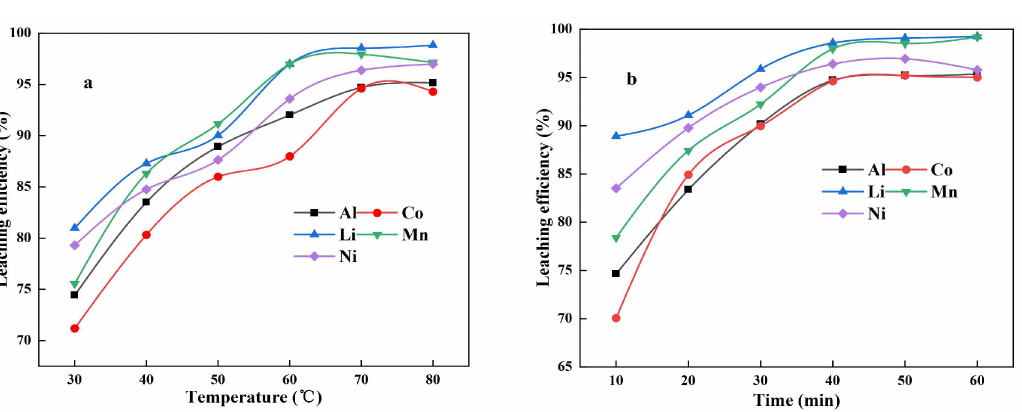
Figure 5. Effects of ( a ) temperature and ( b ) time on the leaching of metals from electrode